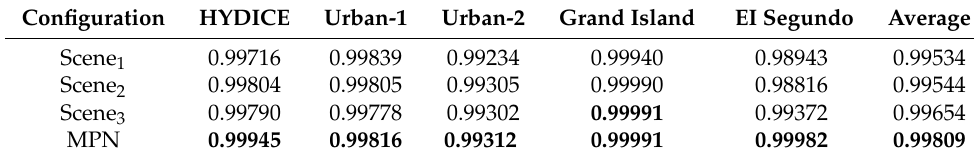
(cid:16) (cid:17) P d , P f for different scenes on different datasets.